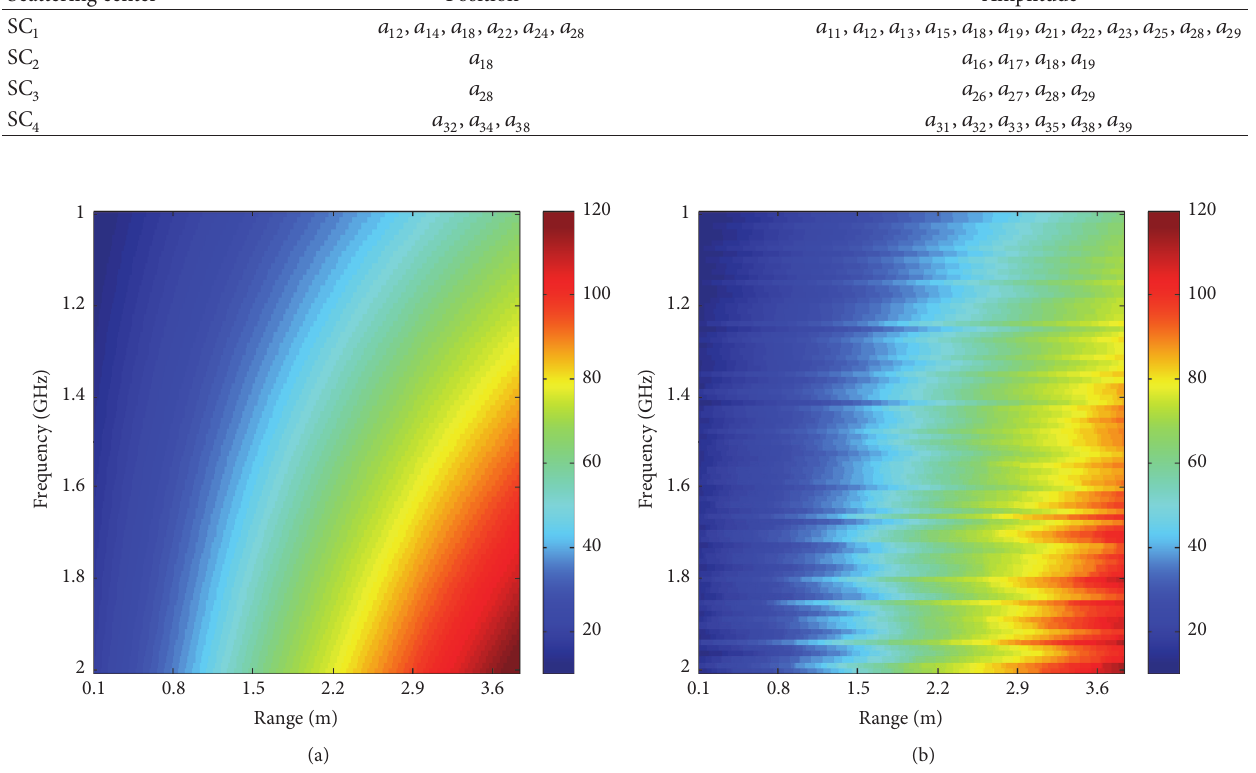
Figure 10: Unwrapped phases of the currents. (a) Simulated currents; (b) real